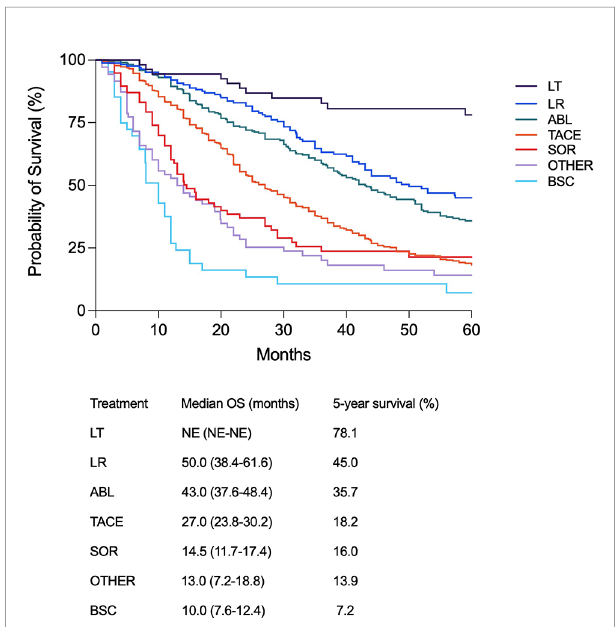
FIGURE 4 | Kaplan – Meier curves showing survival according to the main treatment modality in BCLC B patients (p < 0.0001). Median overall survival and 5-year survival rate are also shown for each treatment